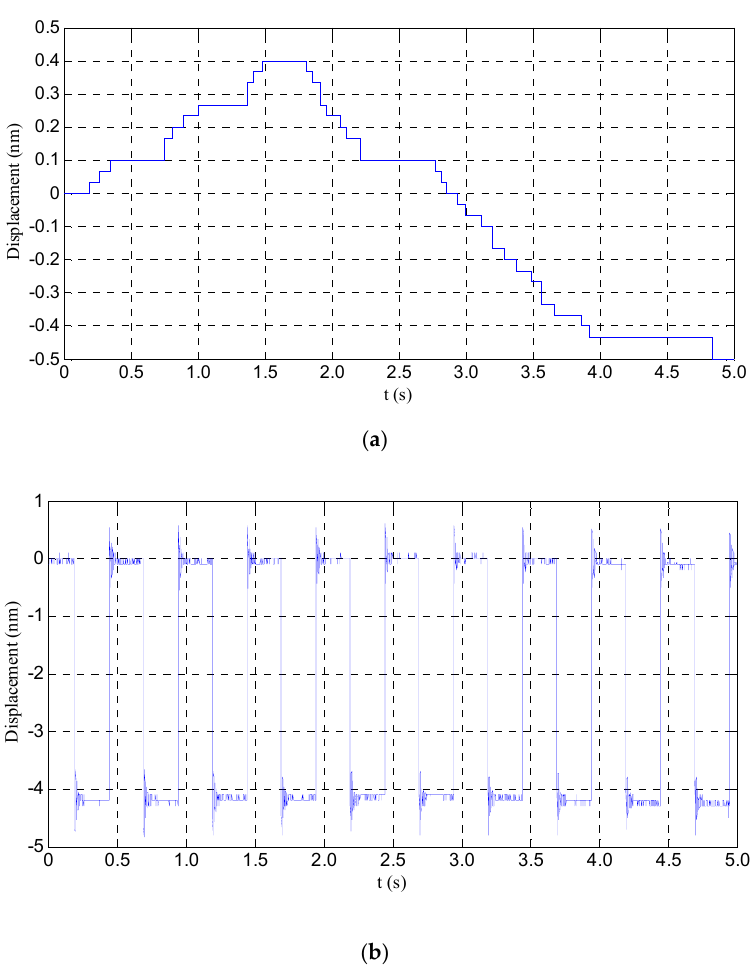
Figure 24. The output displacement resolution of the mechanism: ( a ) the noise of the sensor, and ( b ) the output displacement resolution of the mechanism.